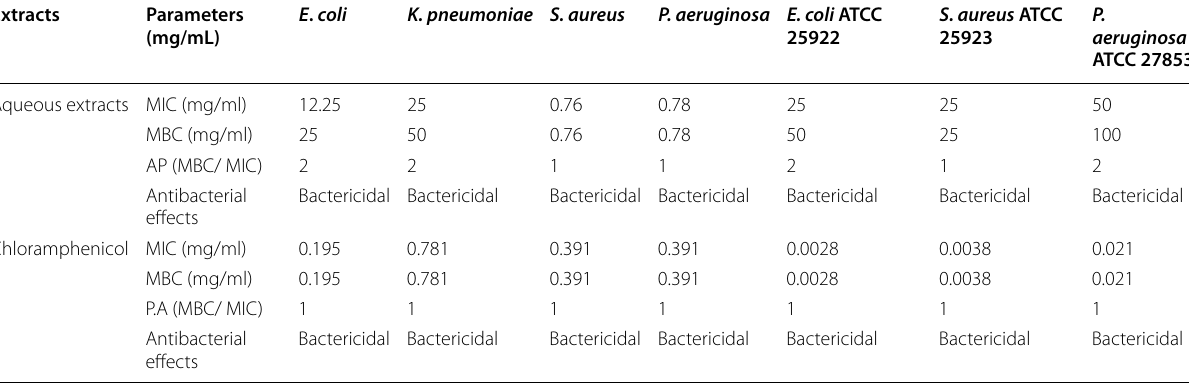
Table 7 Minimum inhibitory and bactericidal concentrations of the aqueous extract of A. cordifolia against the four bacterial strains